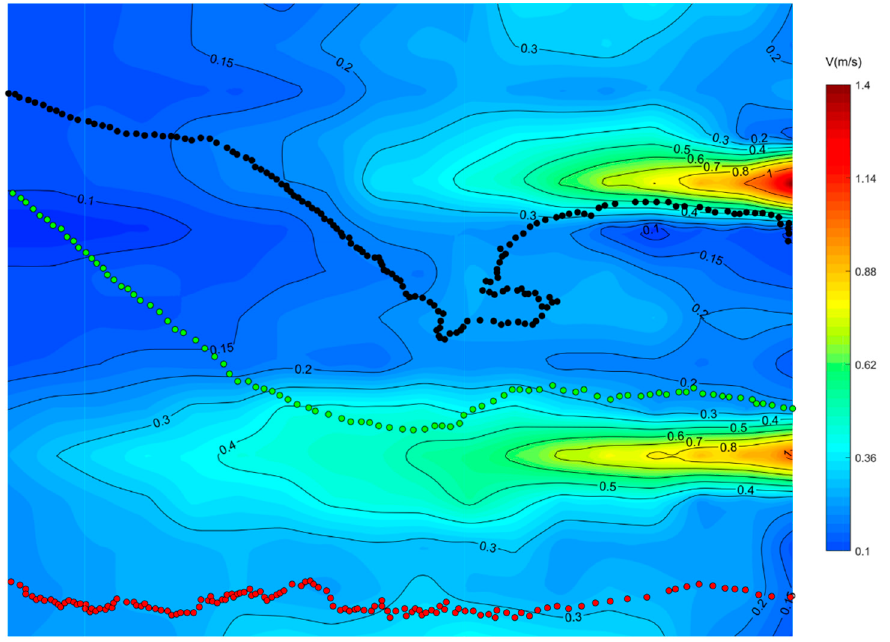
Figure 8. Representative swimming trajectory and flow field superposition in the focused observation cell under the lateral asymmetric bimodal outflow condition.